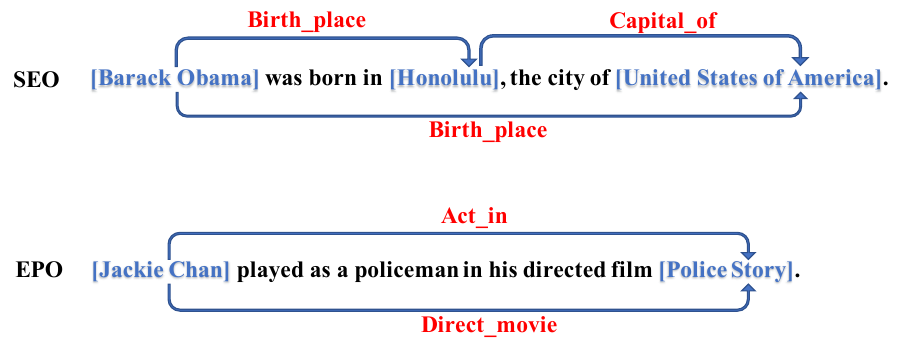
Figure 1. The two examples of overlapping types. Single Entity Overlap (SEO) and Entity Pair Overlap (EPO) overlapping patterns.